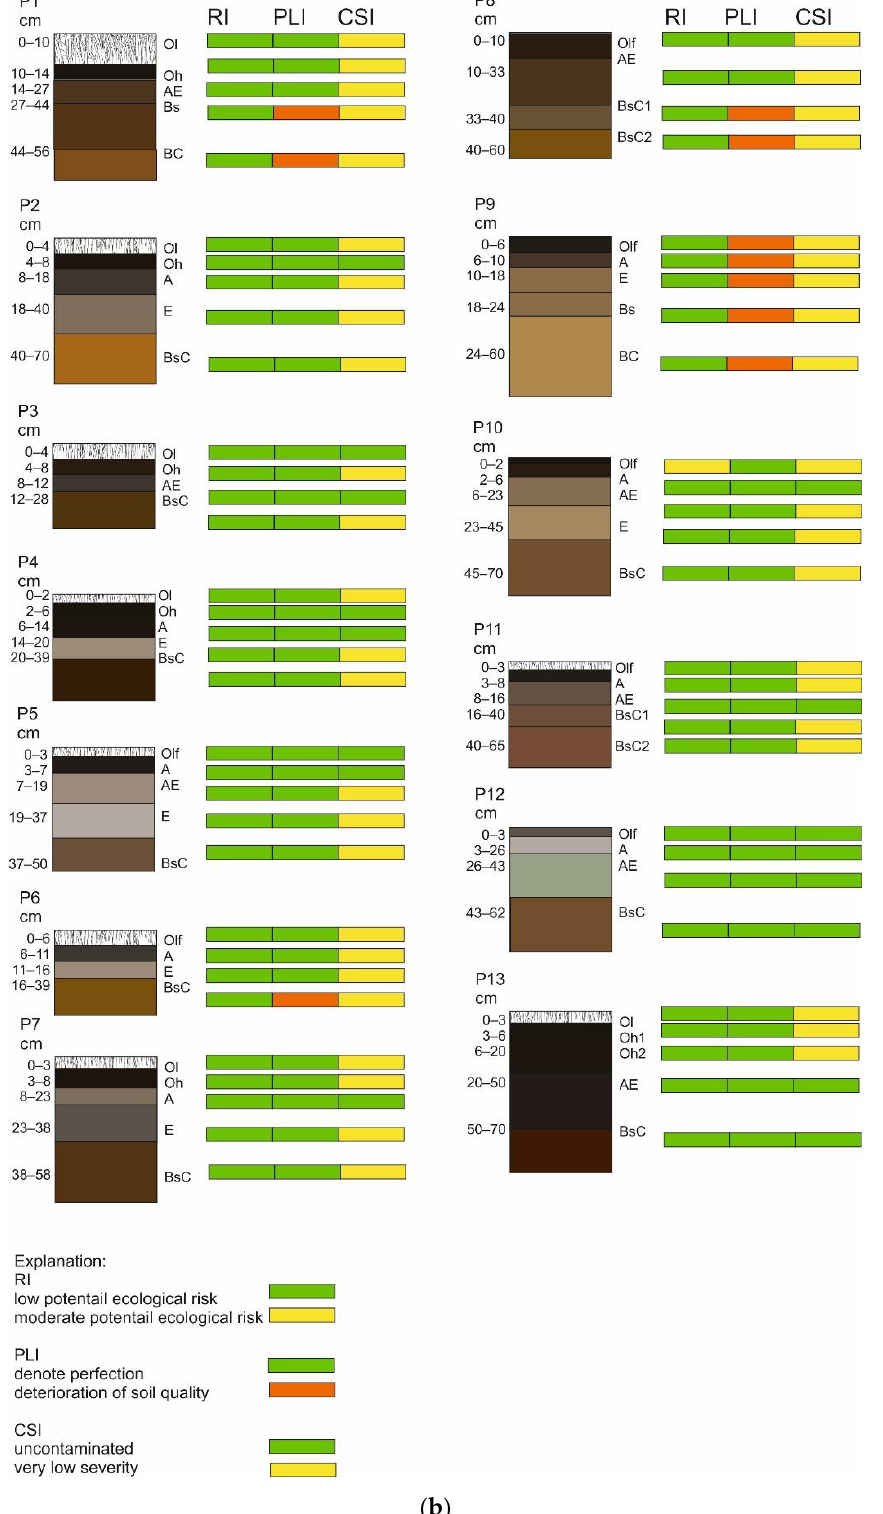
Figure 5. The interpretation of pollution indices values: ( a ) Matrix of Geoaccumulation Index (I geo ) values in studied soils. The interpretation of pollution indices values: ( b ) Potential Ecological Risk (RI), Pollution Load Index (PLI) and Contamination Security Index (CSI) values calculated on the basis of studied trace elements.